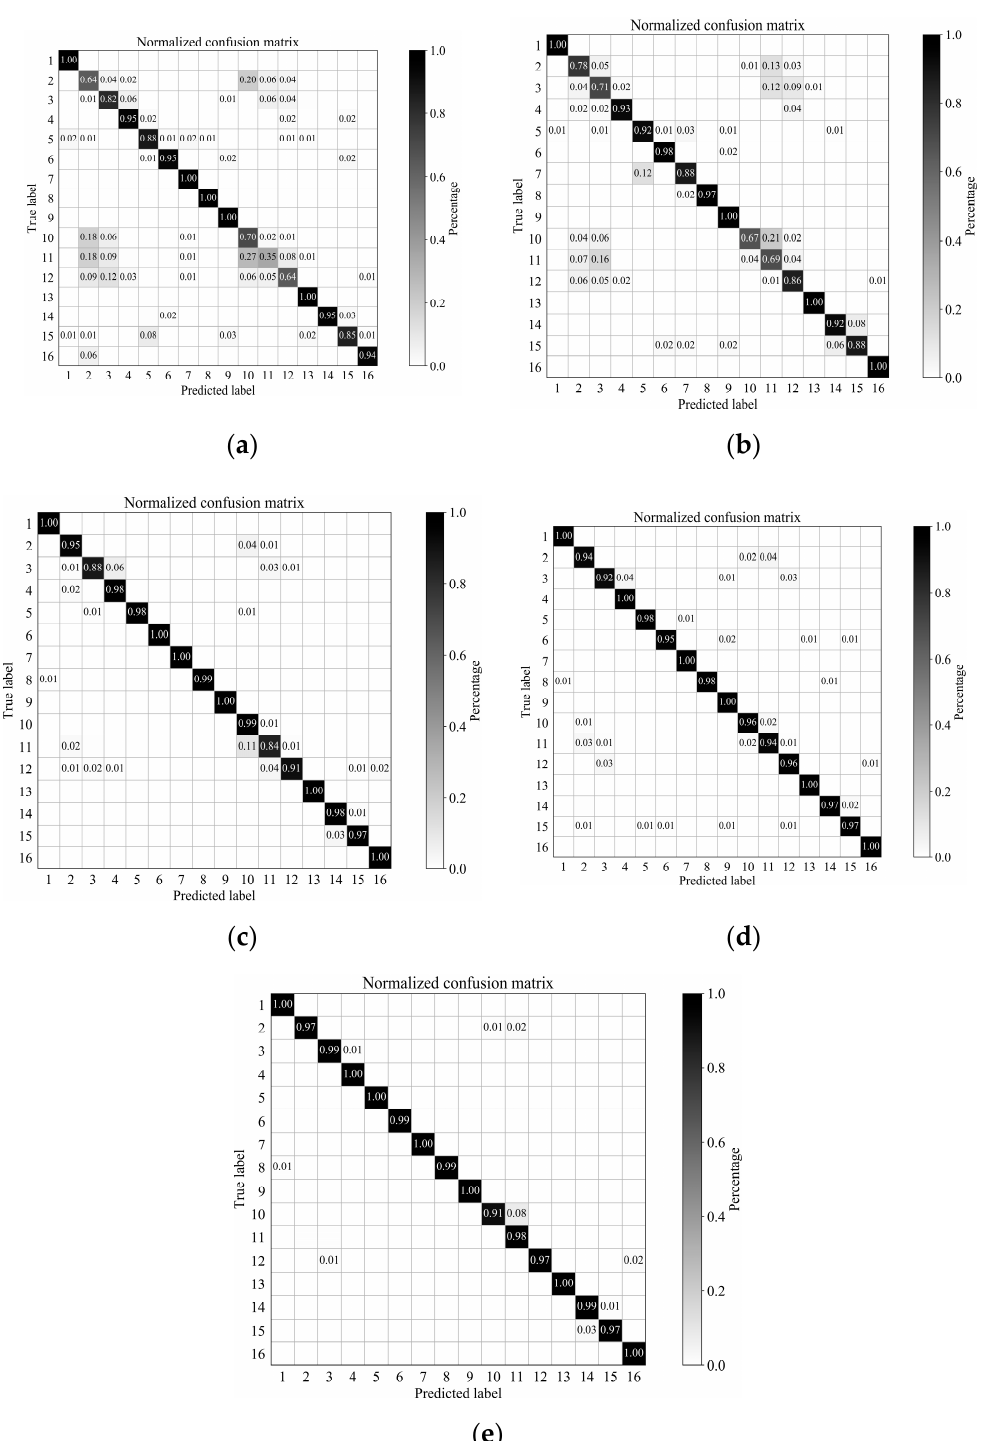
Figure 9. Indiana Pines dataset: Normalized confusion matrix of classification results using different methods (displaying value greater than 0.005): ( a ) SSLSTMs, ( b ) 3D CNN, ( c ) FDSSC, ( d ) SSRN, ( e ) SSCC.